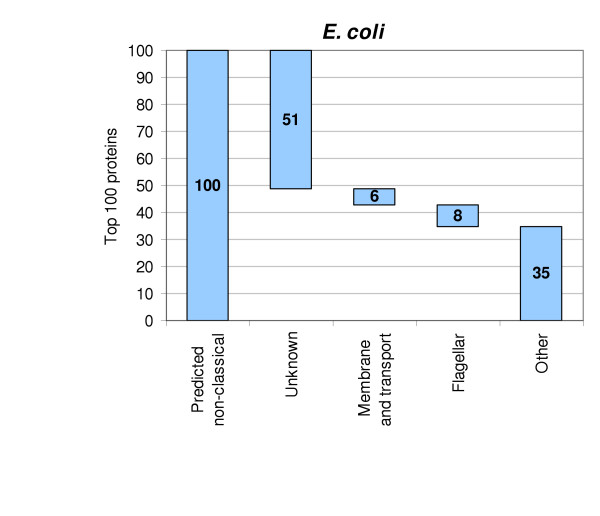
Putative non-classical secretory proteins. The top 100 scoring proteins are grouped based on annotation. Several groups have obvious relations to extracellular functions. For proteins with no annotation (grouped in 'Unknown'), our prediction method suggests an extracellular role. Proteins grouped in 'Other' may have an extracellular function, although this is not apparent in the current annotation.